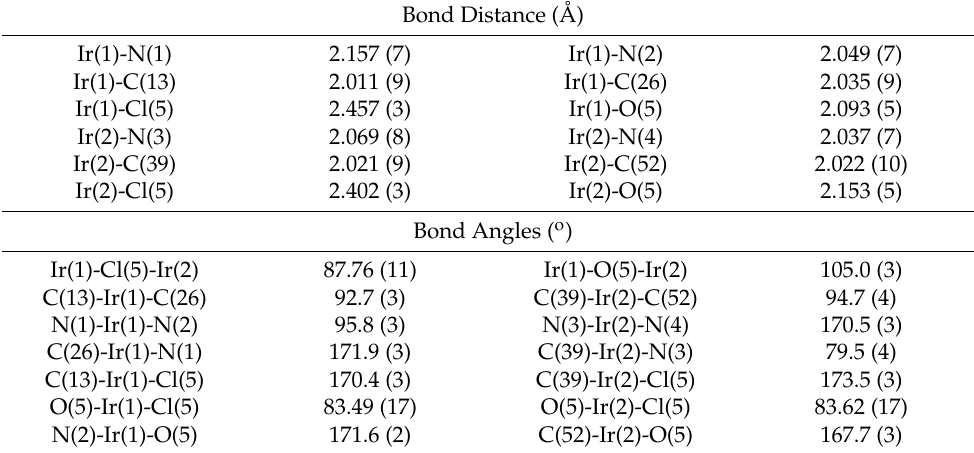
Figure 1. ORTEP plots of 1 . Thermal ellipsoids are drawn at the 30% probability level and hydrogen atoms are omitted for clarity. Table 1. Selected Bond Distance (Å) and Bond Angles for Compound 1